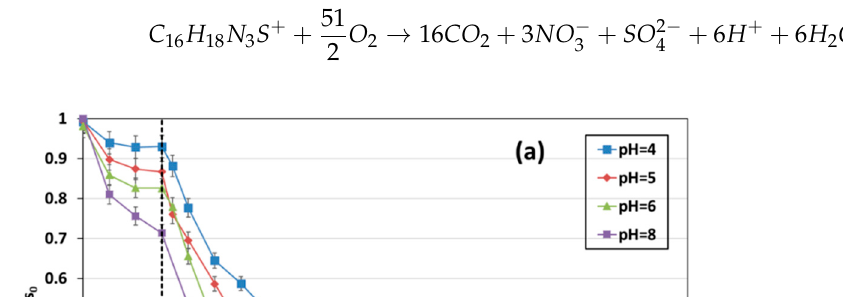
Figure 7. Influence of the aqueous solution salinity in the presence of NaCl ions on the degradation of MB (C 0 = 60 mg/L; pH neutral, D TiO2 = 1 g/L; temperature = 20 ± 2 °C).